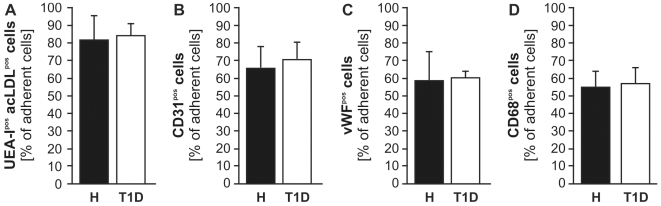
Outgrowth potential of migrating cells.BKmig of both study groups gave rise to equal numbers of UEAIpos acLDLpos (A), CD31pos or vWFpos EC (B and C) or CD68pos macrophages (D). Values are mean±SEM. n = 6 per group.